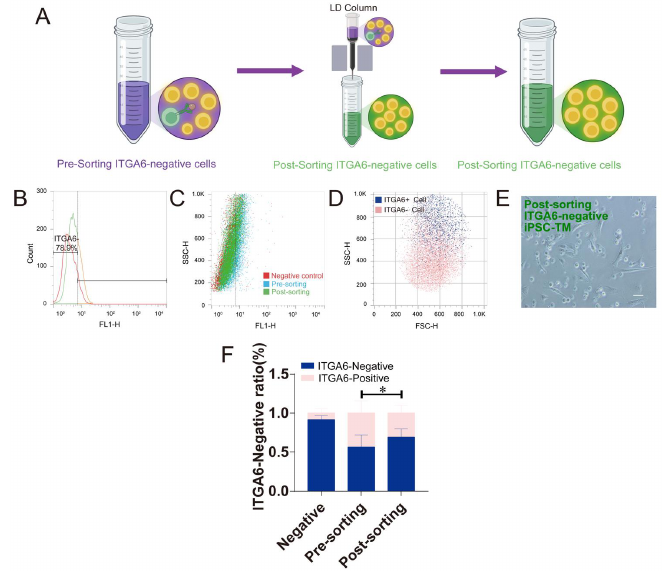
Figure 3. The magnetic platform to purify ITGA6-negative iPSC-TM. ( A ) Schematic illustration of the ITGA6-negative iPSC-TM purification process by the magnetic platform. The ITGA6-negative iPSC-TM after LS-based purification was collected in a purple tube and used for the LD-based purification. Post-sorted ITGA6-negative iPSC-TM in a green tube was used for the flow cytometry analysis. ( B – D ) The histogram analysis ( B ), fluorescence density plot (FL1-H vs. SSC-H; C ), and FSC-H vs. SSC-H plot ( D ) showing the ratios of the ITGA6-negative cells in the negative control (red), pre-sorted iPSC-TM (blue), and post-sorted iPSC-TM (green). ( E ) A representative image showing the morphology of ITGA6-negative iPSC-TM after the LD-based sorting. Scale bars, 50 µm. ( F ) Quantification analysis of the ratios of ITGA6-positive cells (pink) and ITGA6-negative cells (blue) based on six experimental repeats. One round of LD-based purification significantly increased the ratio of ITGA6-negative cells (pre-sorting vs. post-sorting: 0.61 ± 0.04 vs. 0.73 ± 0.02, * p < 0.05). P value was analyzed by one-way ANOVA.